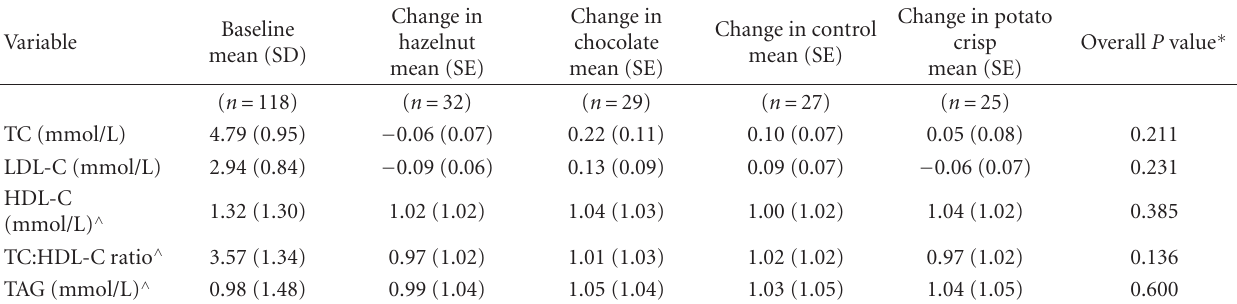
Table 4: Blood lipid profile and changes in the biochemical indices from baseline to Week 12 for each group.